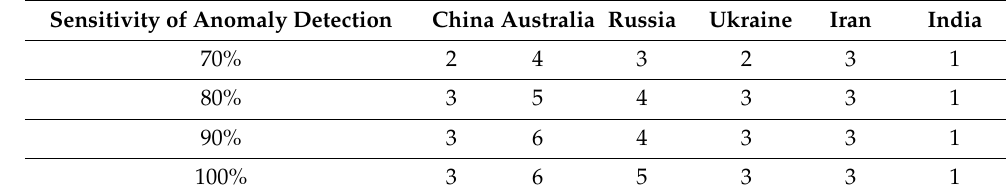
Table 8. Numbers of anomalies detected with different percentages of sensitivity.